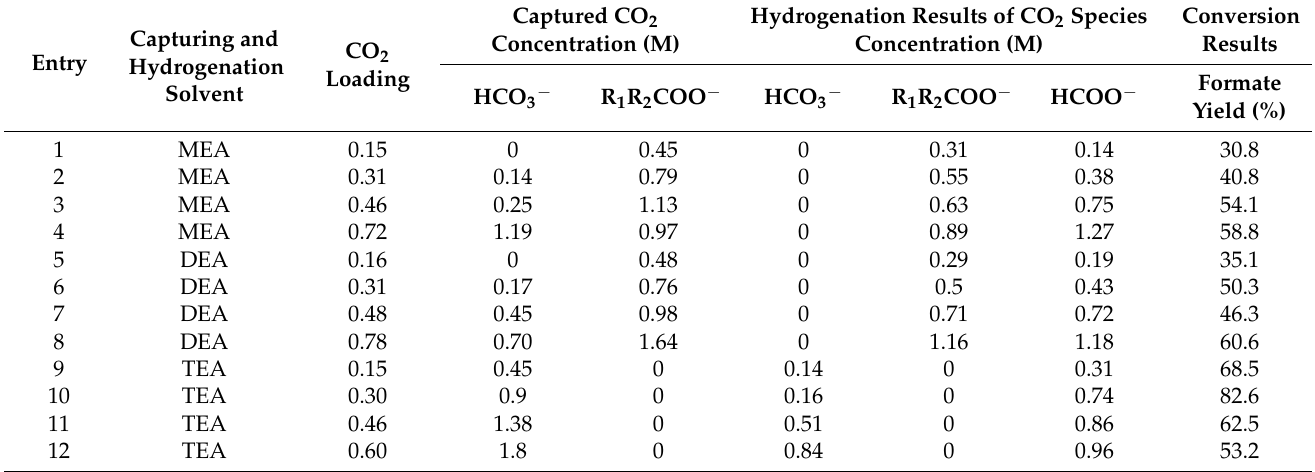
Table 1. Results of integrated CO 2 capture and hydrogenation to produce formate in aqueous amine solutions of MEA, DEA and TEA in the presence of Pd/NAC